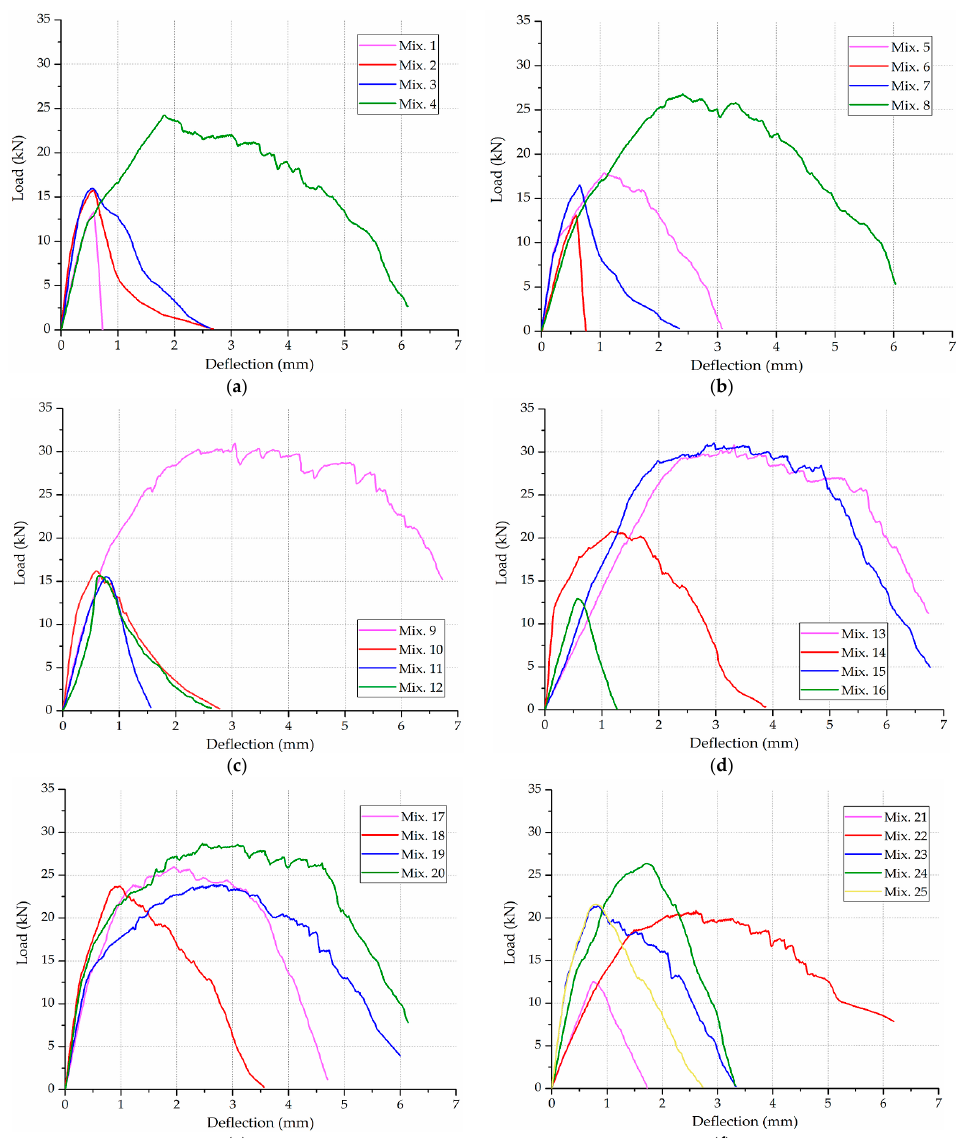
Figure 7. The flexural load-deflection curves before the freeze-thaw test for: ( a ) Mix. 1~4; ( b ) Mix. 5~8; ( c ) Mix. 9~12; ( d ) Mix. 13~16; ( e ) Mix. 17~20; ( f ) Mix. 21~25. The load-deflection curve varies in shape according to the set of mix design. Generally, the fibrous ECC specimens (e.g., Mix. 9, 13 and 15) exhibit superior load capacity and post-cracking performance to the plain specimens (e.g., Mix. 1, 6 and 11). The larger area under the load-deflection curve up to a specified deflection for the specimen reinforced with PVA fiber indicates its better